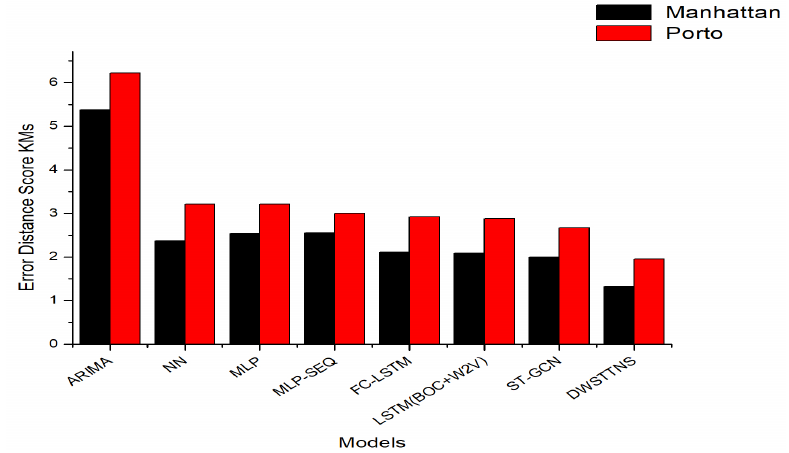
Figure 8. Porto and Manhattan error distance score comparison with previous models.